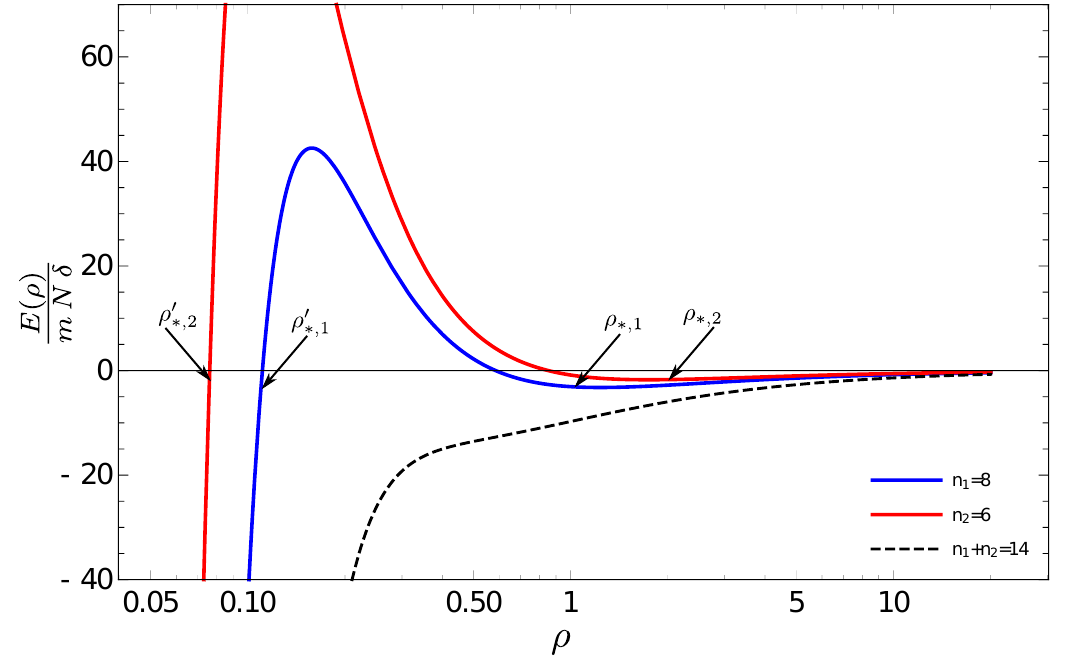
Figure 1 . The two solid lines denote the rescaled energy functionals of two stable ASts in the vicinity of (cid:26) (cid:3) , which have n 1 = 8 (blue) and n 2 = 6 (red). The points labeled in the graph are: the local minimum of ASt 1 (2), (cid:26) (cid:3) ; 1 ( (cid:26) (cid:3) ; 2 ), and the isoenergetic point on the left of the